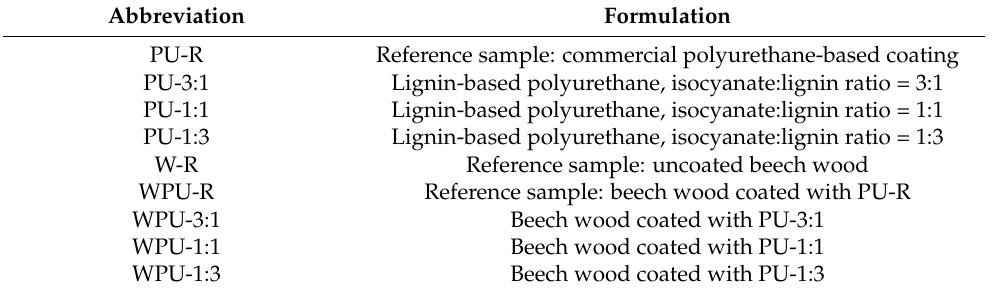
Table 1. Formulations of the different coatings and corresponding abbreviations used in the